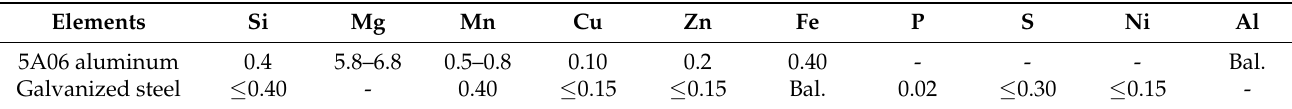
Table 1. Chemical composition of base materials.